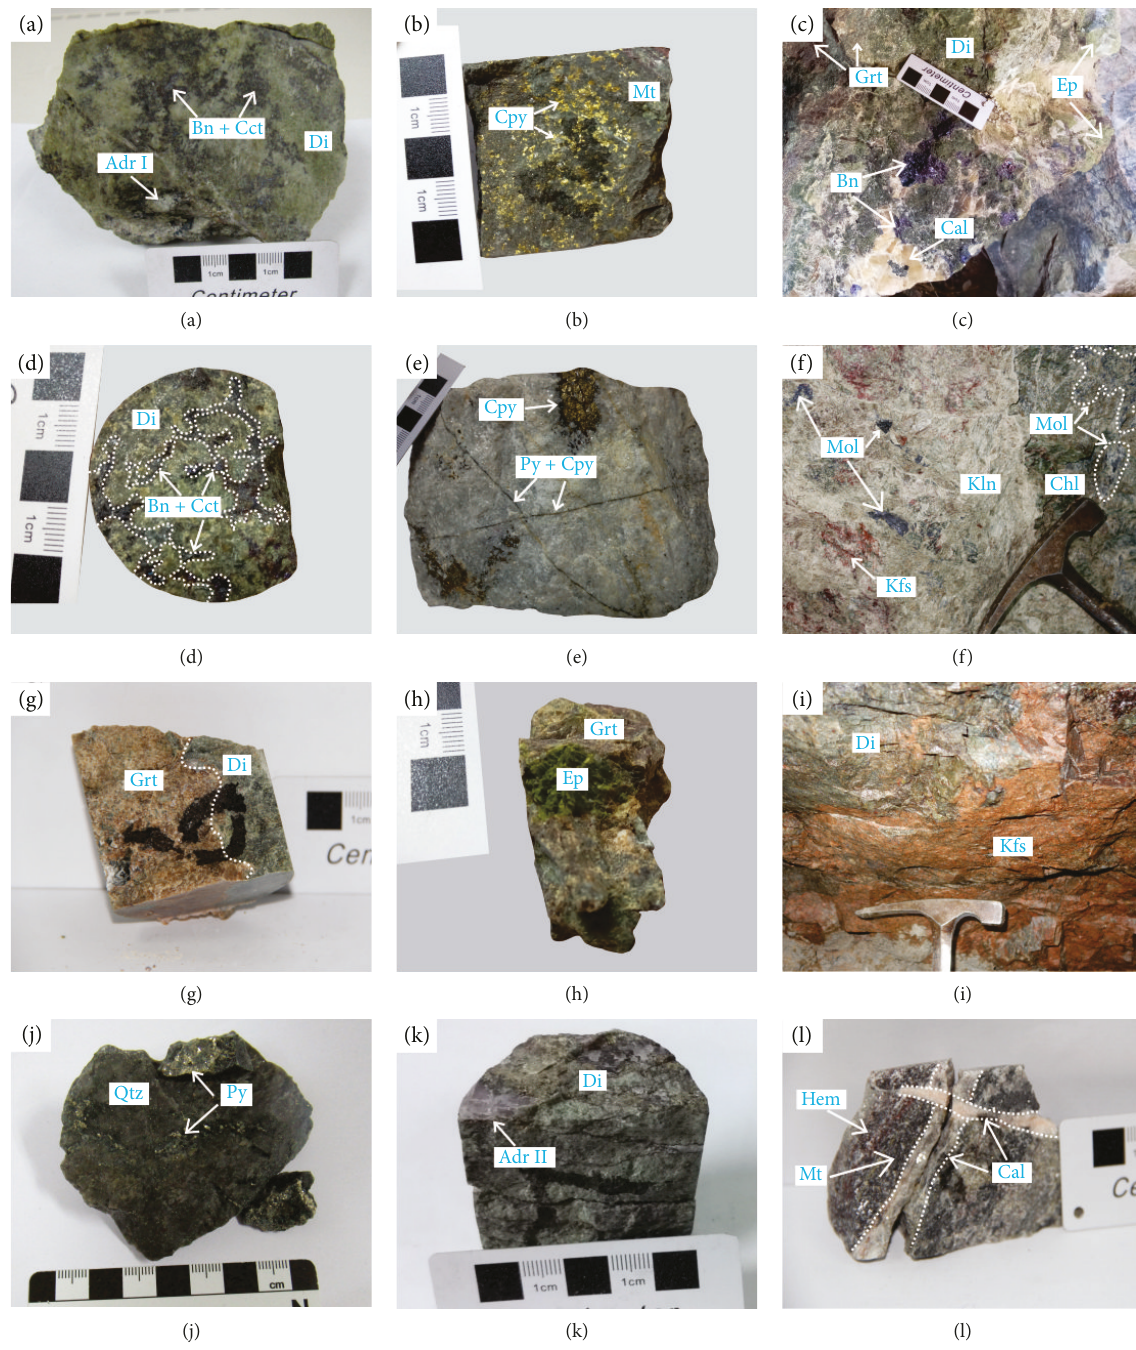
Figure 5: Photographs of hand specimens showing the mineral assemblages, structures, and di ff erent kinds of alterations of the Fuzishan Cu-Mo deposit. (a) Interstitial bornite, chalcocite, and late anhydrite in diopside skarn. (b) Disseminated chalcopyrite overprinting magnetite. (c) Massive bornite ores together with coexisting calcite replacing previously formed garnet, diopside, and epidote. (d) Stockwork bornite and chalcocite ores in diopside skarn. (e) Chalcopyrite and pyrite occurring as small lumps or veinlets in marble. (f) Chloritization and kaolinization together with speckled molybdenum mineralization superimposed on ambiguous potassic feldspathization. (g) Prograde skarn stage containing minerals of garnet and diopside. (h) Retrograde skarn stage epidote replacing prograde skarn garnet. (i) Quartz diorite with potassic feldspathization and minor diopside-bearing skarnization. (j) Silici fi cation comprising light grey quartz and coexisting disseminated pyrite. (k) Late anhydrite displaying as light purple, transparent vein crosscutting diopside skarn. (l) Carbonate stage calcite veins cutting hematite and magnetite. Py: pyrite; Cpy; chalcopyrite; Bn; bornite; Cct: chalcocite; Mol: molybdenite; Mt: magnetite; Hem: hematite; Grt: garnet; Di: diopside; Ep: epidote; Kfs: k-feldspar; Adr I: early anhydrite; Adr II: late anhydrite; Chl: chlorite; Kln: kaolinite; Cal: